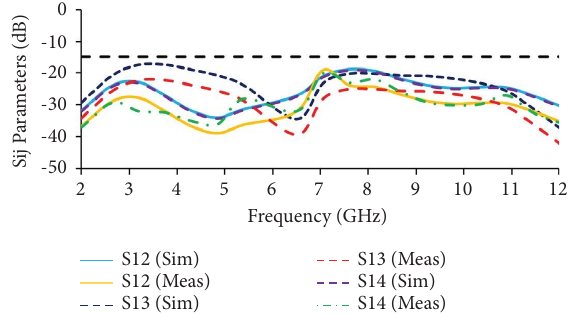
Figure 11: S ij -plots of the proposed MIMO